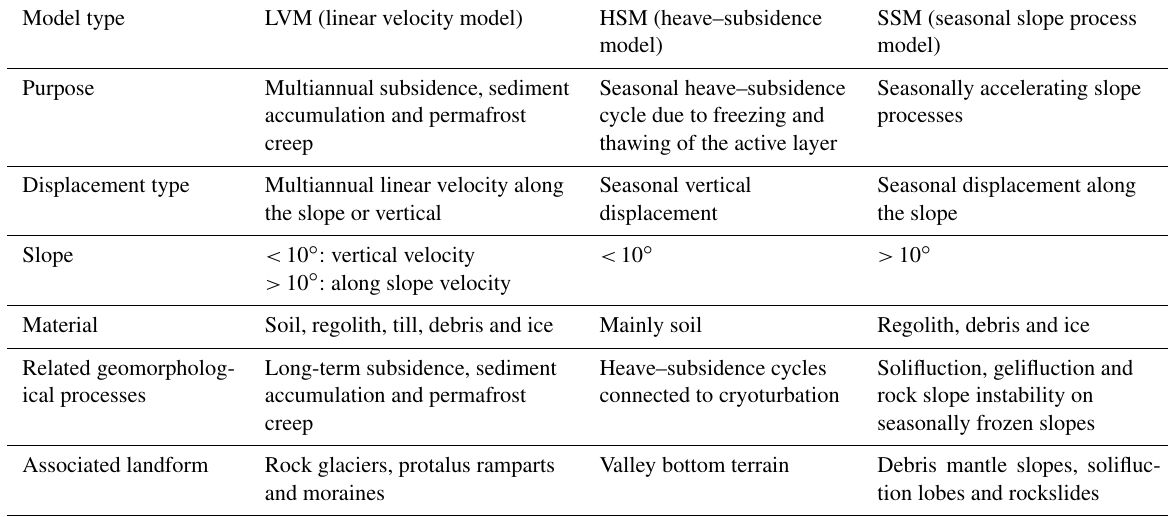
Table 2. Overview of the three surface displacement models with information regarding their purpose, displacement patterns and their connections to geomorphological und geological